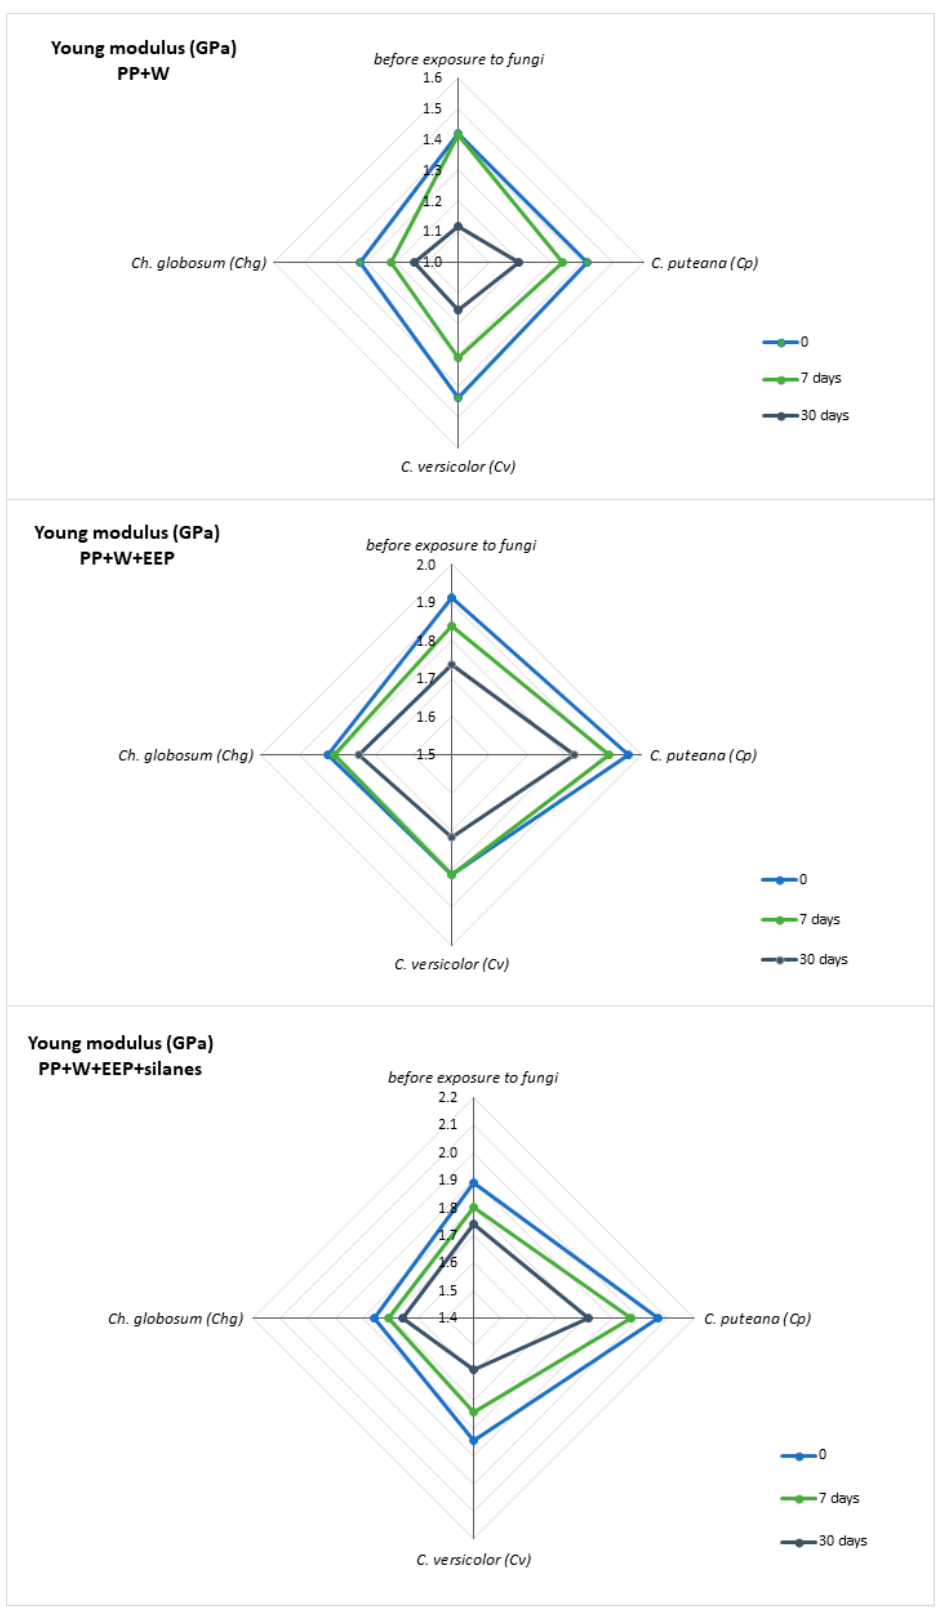
Figure 9. Young’s modulus of composites before and after UV radiation and fungal